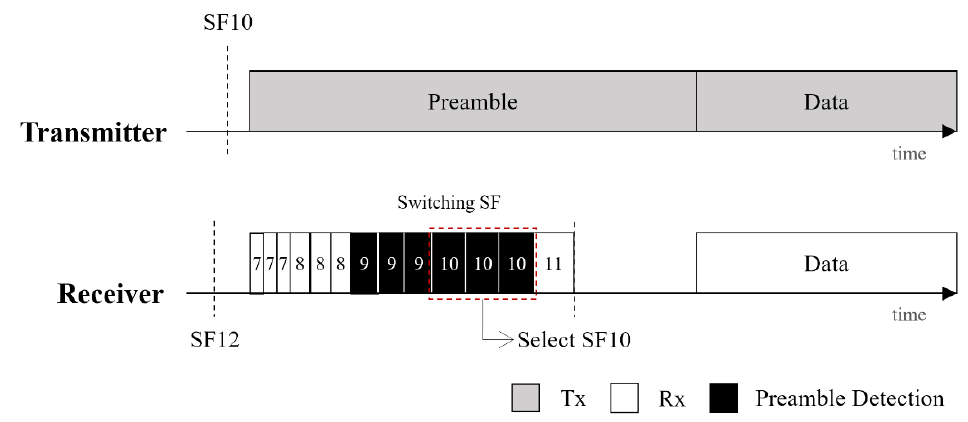
Figure 4. An example of the SF selection algorithm.